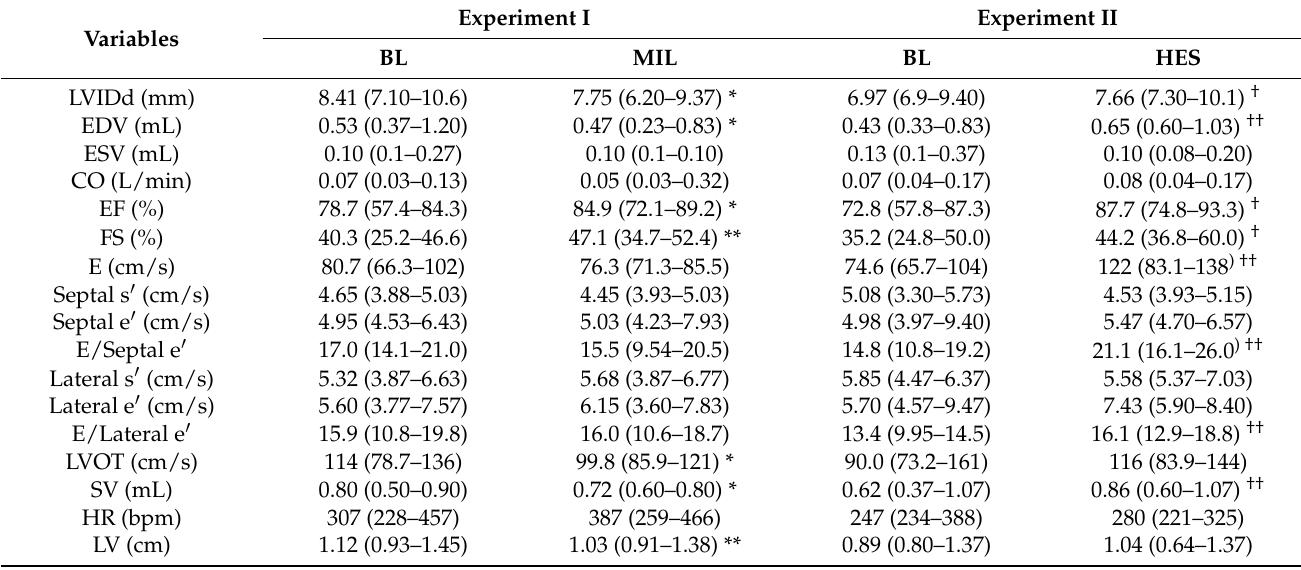
Table 1. Effect of various loading conditions on conventional echocardiographic parameters.